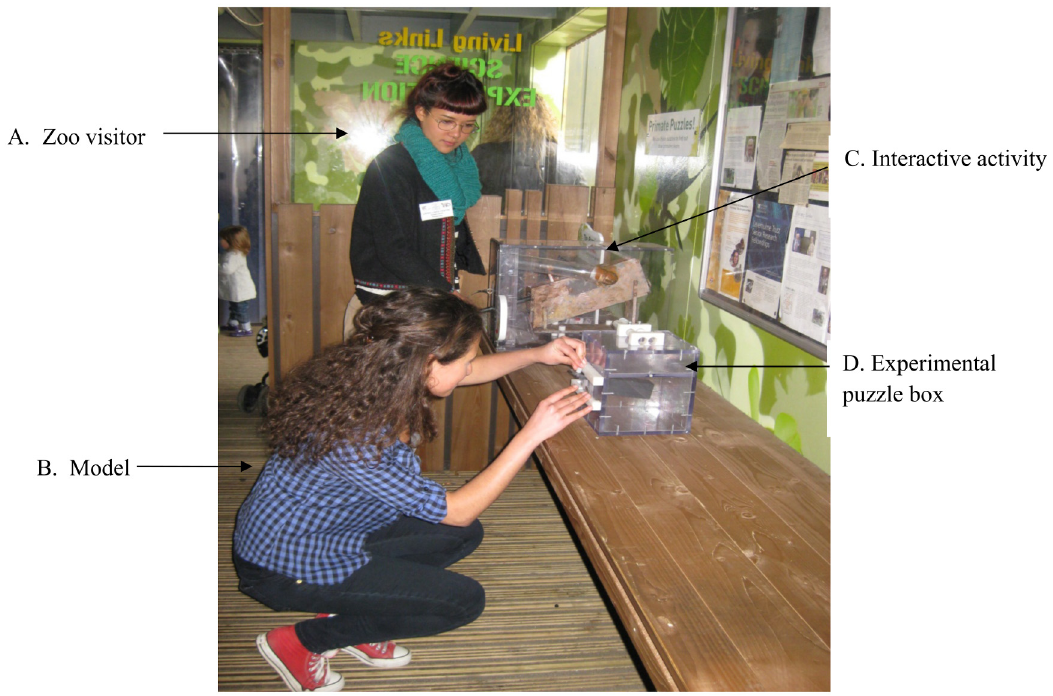
Fig 2. Illustration of the experimental set-up in the Science Exploration Zone of Living Links. Experimenter 2 acting in the role of a zoo visitor (A) observes Experimenter 1 (B) manipulating the experimental puzzle box (D). The puzzle box is situated amongst other interactive activities (C) available for the public to